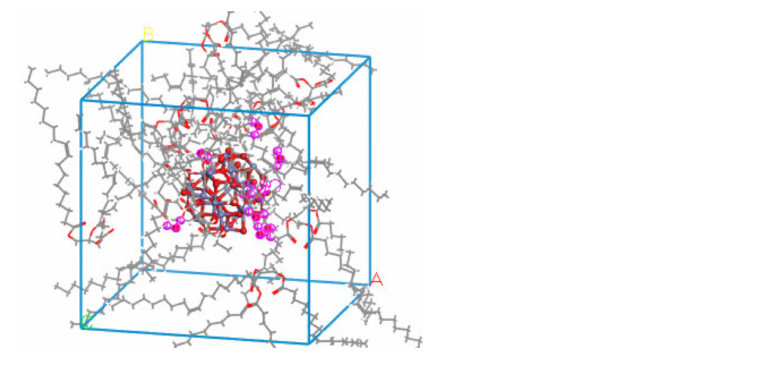
Figure 10. Distribution of water molecules in the nano-Fe 3 O 4 -modified